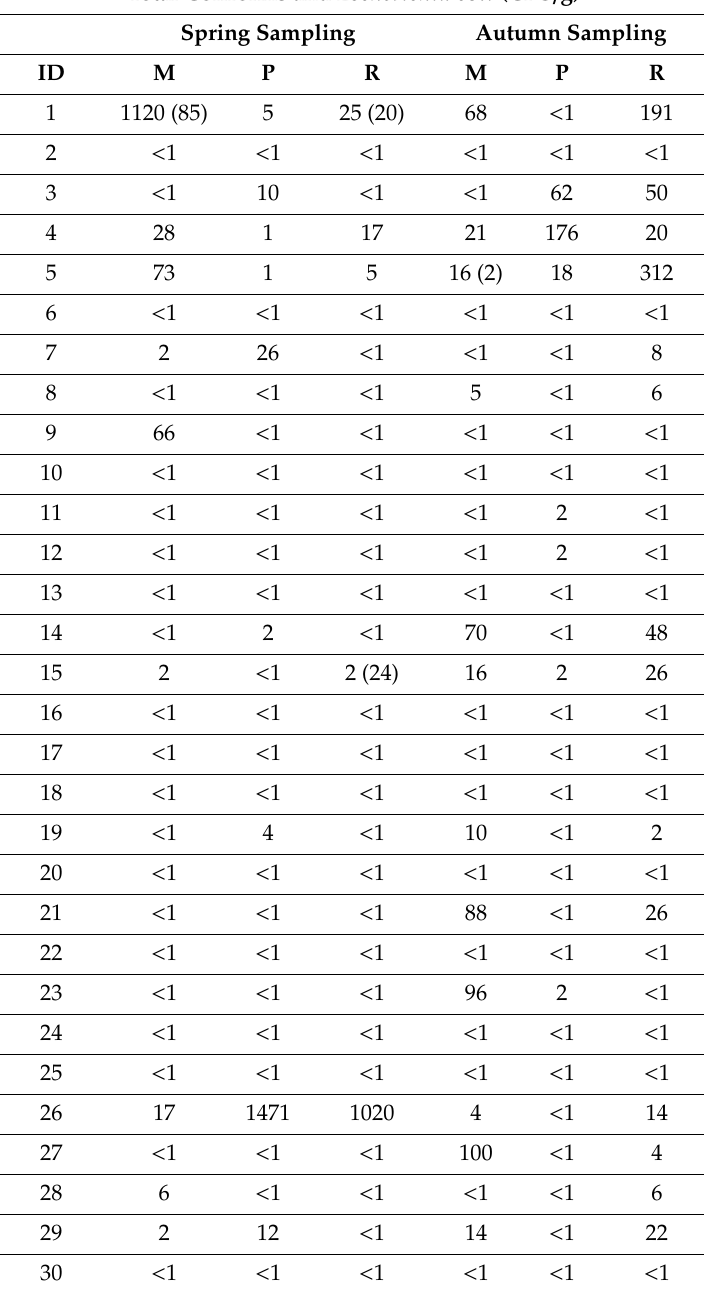
Table 4. Total coliforms and E. coli . Microbial counts are reported for both indicator parameters. The first number refers to total coliforms whilst the one in round brackets to E. coli colonies. M—maturing mud, P—peloid, R—regenerating used